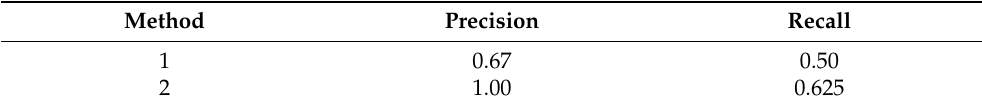
Table 2. Precision and recall for methods 1 and 2.